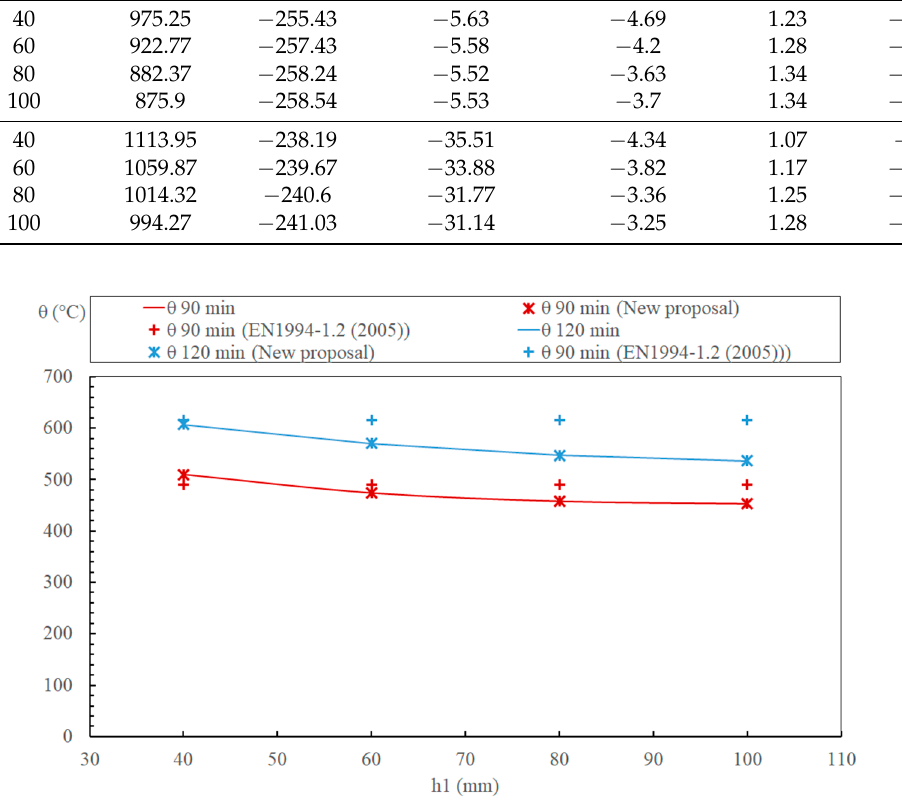
Figure 10. Temperature of the rebar component for Multideck 50 under Parametric fire curve 3 and standard fire, for the fire rating period of 90 and 120 min. (ANSYS results and new proposal).